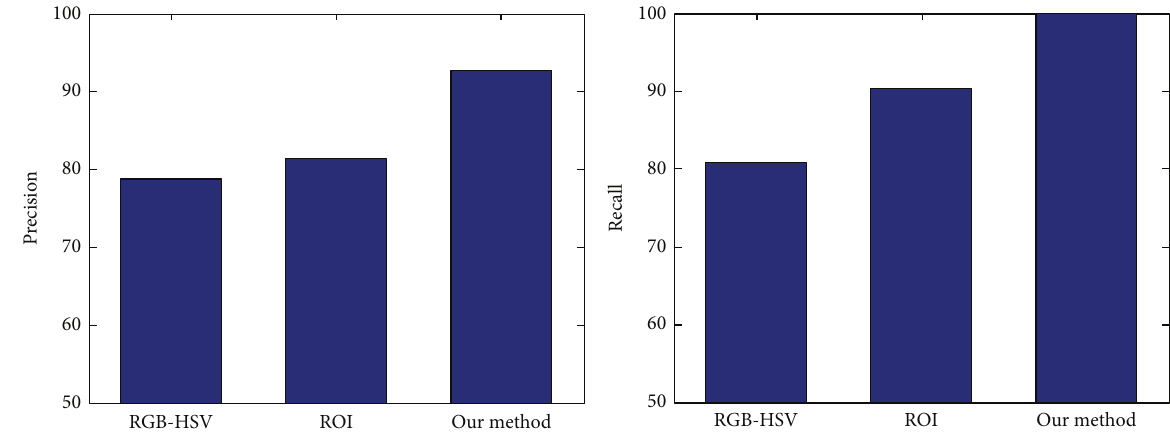
Figure 9: Average precision and average recall of three